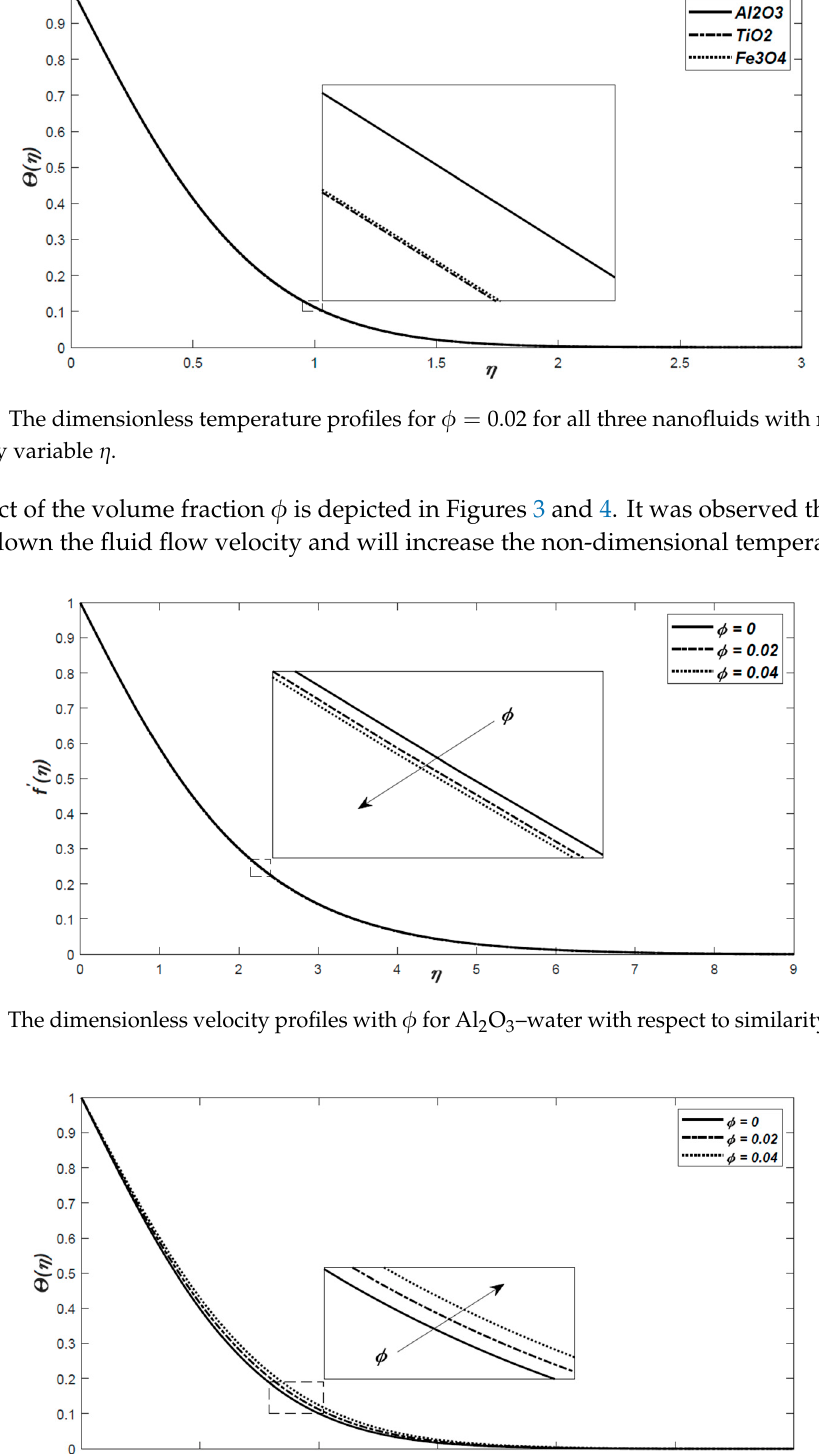
Figure 1. The dimensionless velocity profiles for volume fraction 𝜙 = 0.02 for all three nanofluids with respect to similarity variable 𝜂 .